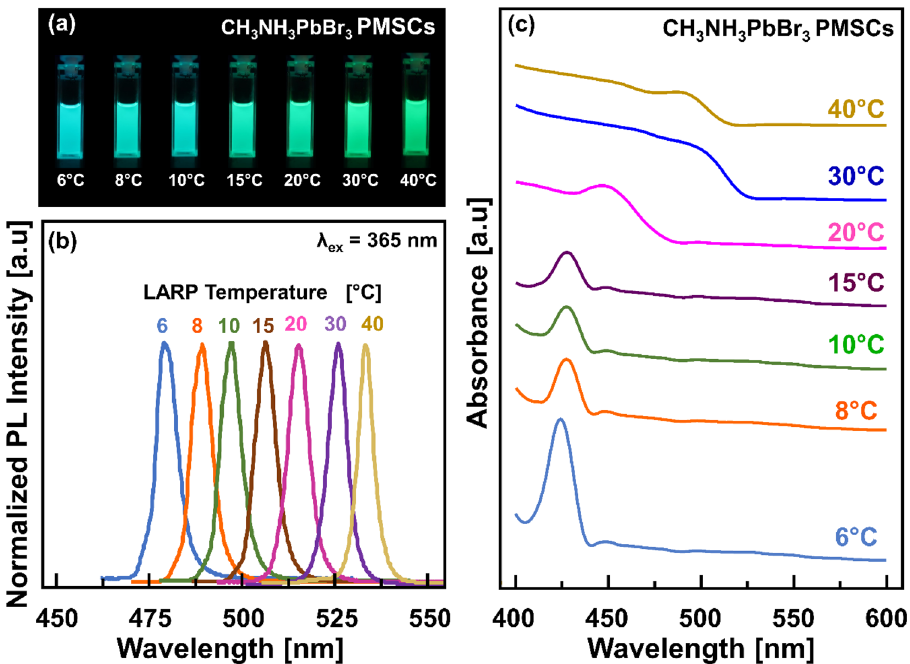
Figure 1. Optical properties of the as-synthesized CH 3 NH 3 PbBr 3 PMSCs in varying precipitation temperature. ( a ) Digital photograph of the luminescence of samples under 365 nm UV irradiation. ( b ) PL spectra of all samples under 365 nm UV excitation. ( c ). Optical absorption spectra of the samples.